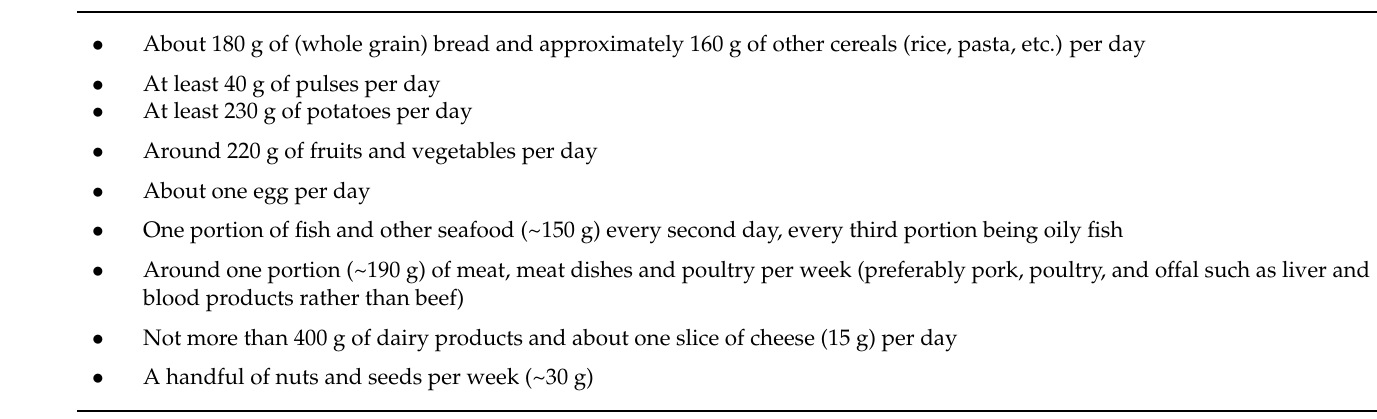
Table 4. Quantities of food groups for an omnivorous diet with 2410 kcal, generating a maximum of 1571 g of CO 2 eq/day, based on the “Omni+”